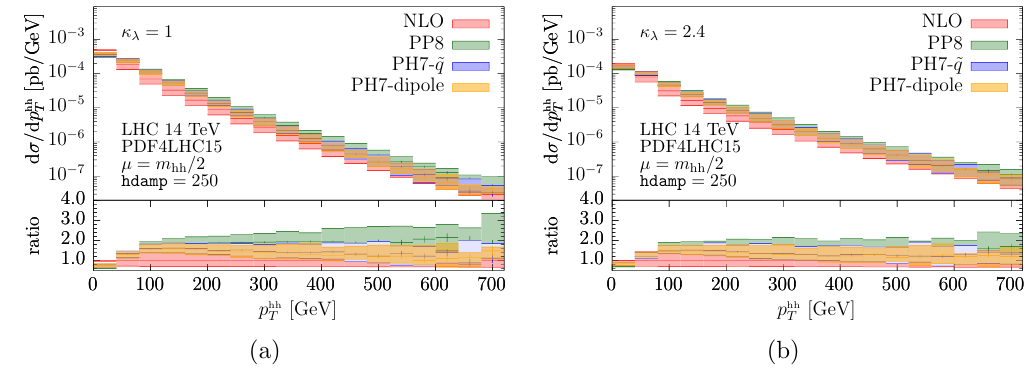
Figure 6. Transverse momentum of the Higgs boson pair for the (cid:12)xed-order NLO calculation and all three shower setups at 14 TeV for (a) (cid:20) (cid:21) = 1, (b) (cid:20) (cid:21) = 2 : 4.